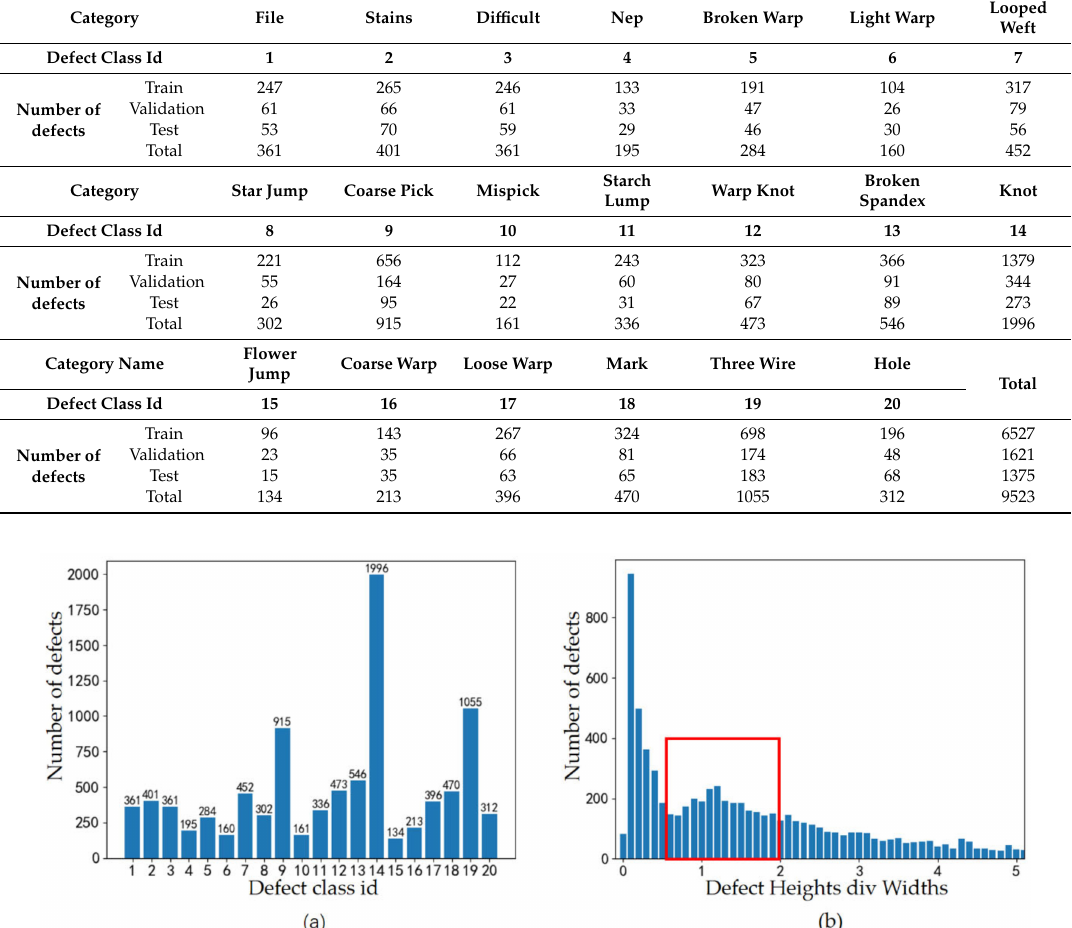
Table 2. Number of each category defects of the denim dataset.